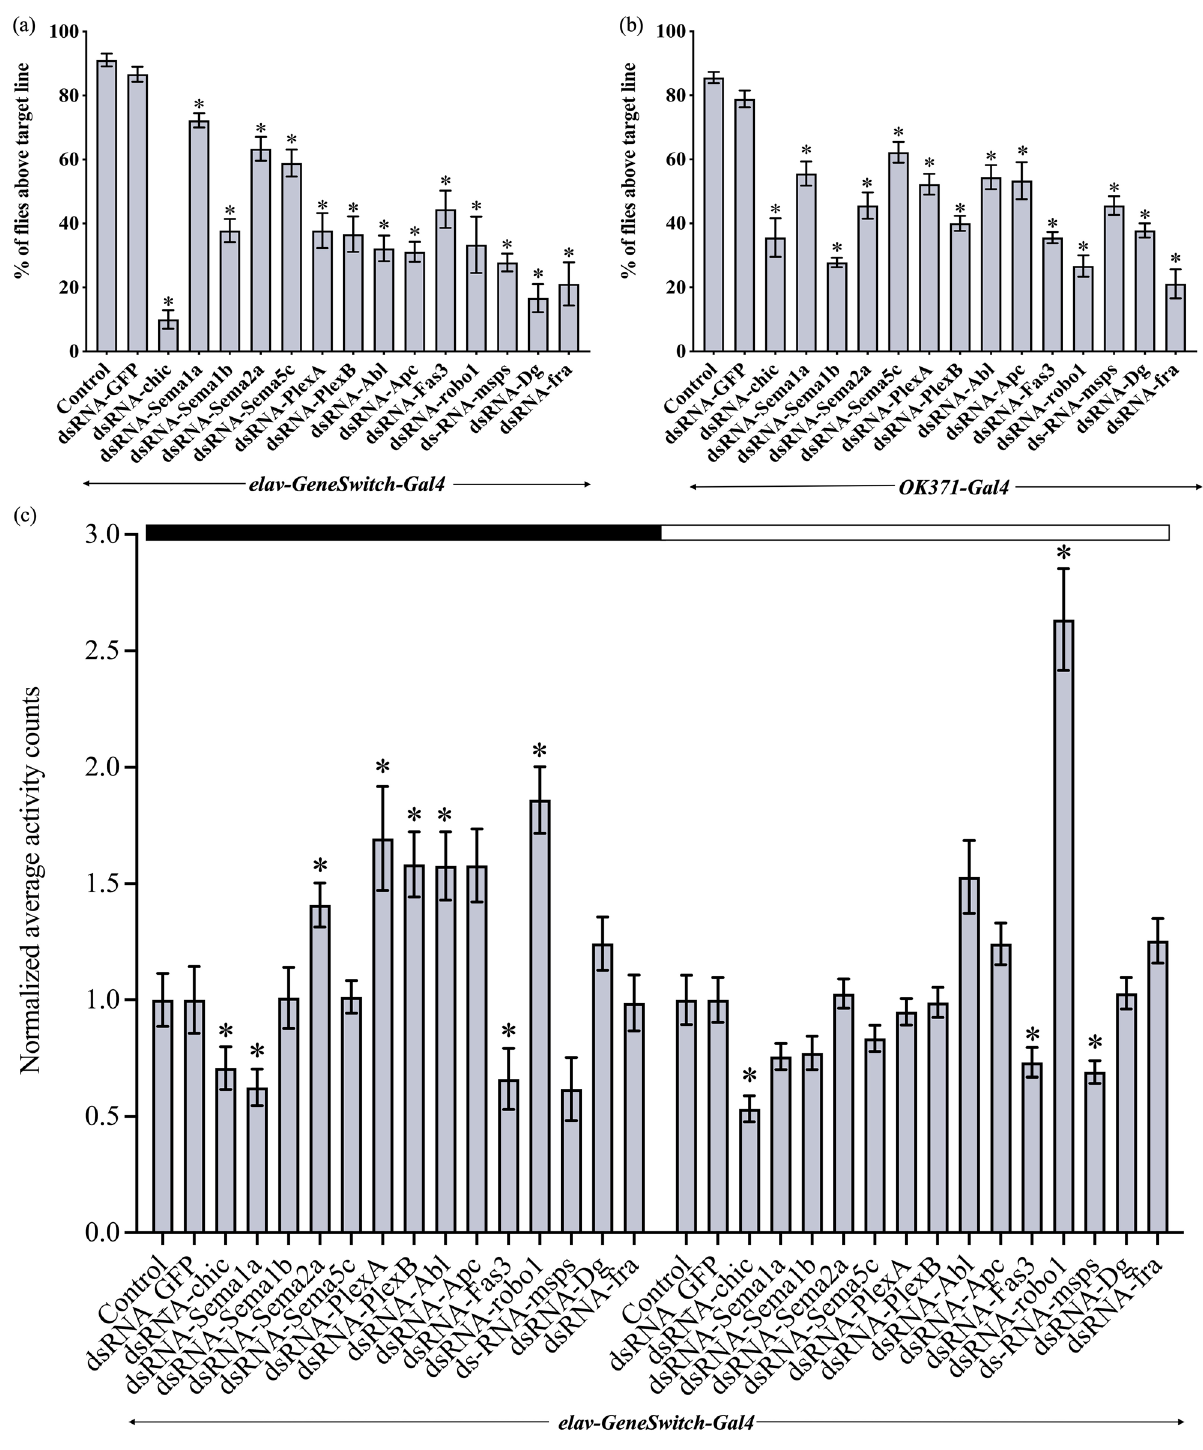
Figure 3. Motility is impacted by the knockdown of specific axon guidance genes ( a ) Effect of pan-neuronal knockdown of axon guidance genes (using elav - GeneSwitch-Gal4 ) on adult climbing behaviour. A significant decrease in adult climbing ability was observed after the knockdown. ( b ) Similar observations were made when each gene was knocked down specifically in glutamatergic motor neurons using the OK371-Gal4 . Data shown are mean ± SEM (‘*’ denotes a significant difference from the control and dsRNA-GFP; p < 0.05, one- way ANOVA and Tukey’s multiple comparison tests; n = 90). ( c ) Effect of pan-neuronal knockdown of axon guidance genes (using elav - GeneSwitch-Gal4 ) on adult activity (measured using DAM). The bar graph compares the normalized average activity counts per 12 h for each gene from multiple flies over a period of 3 days in 12 h light and 12 h dark cycle. The black portion (0–12 h) represents the dark cycle, and the white portion (12–24 h) represents the light cycle. Data shown are mean ± SEM (‘*’ denotes a significant difference from the control and dsRNA-GFP; p < 0.05, one-way ANOVA and Tukey’s multiple comparison tests; n =